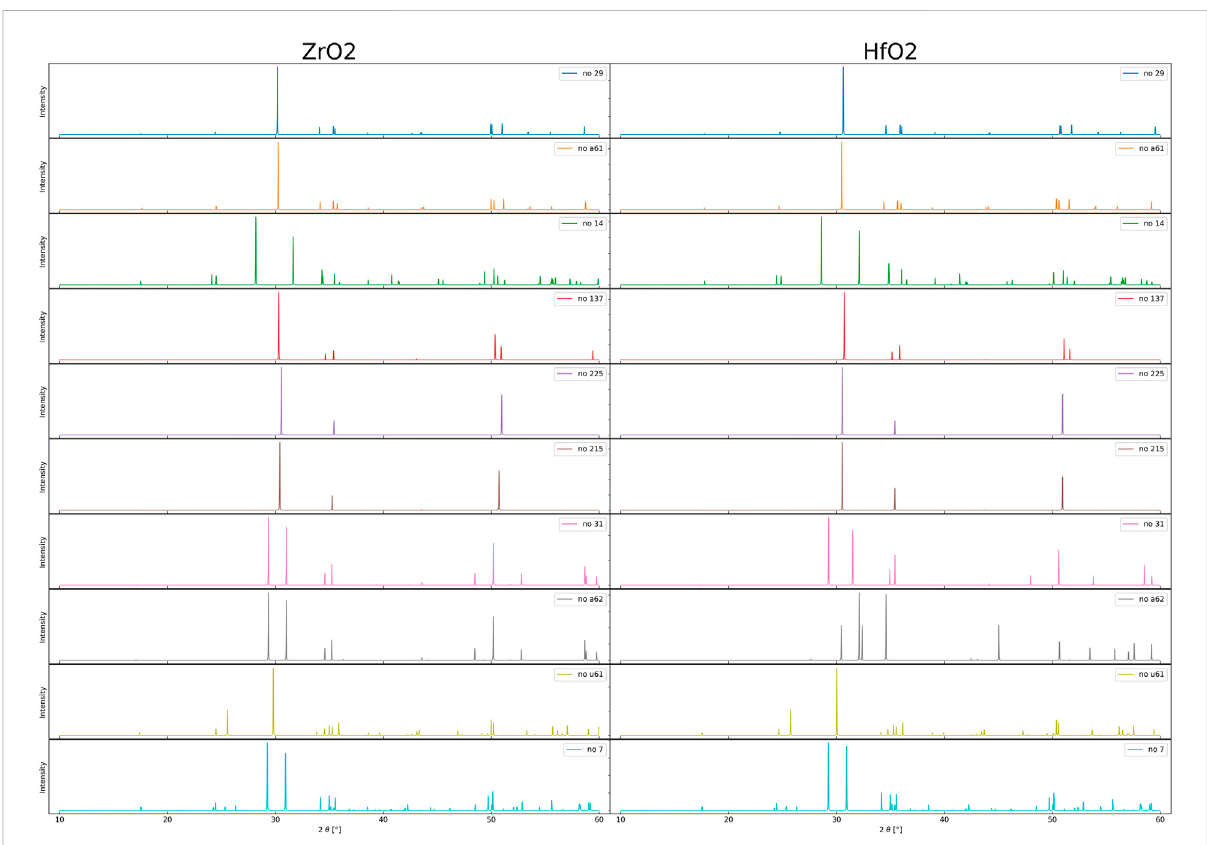
FIGURE 3 Displayed are the simulated XRD-spectra of undoped ZrO 2 and HfO 2 crystal phases. The data are based on structural results obtained from the PBEsol density functional. Due to their distinctive peaks and the widespread usage of XRD in experiments, we chose to base our clustering on XRD-